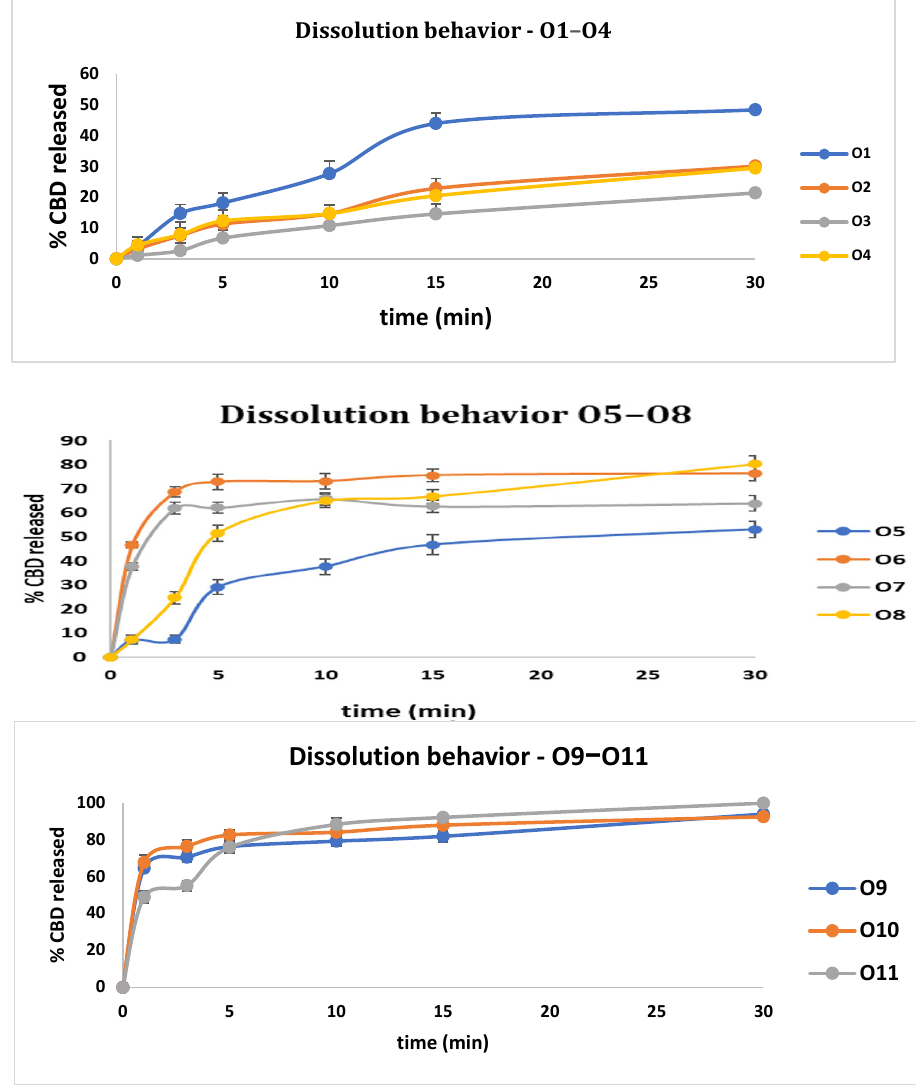
Figure 1. Dissolution profiles of the CBD ODT formulations.